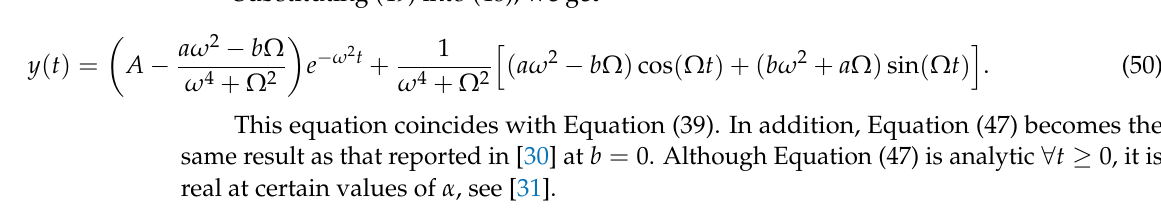
, and Ω = 2 for α = 1 2